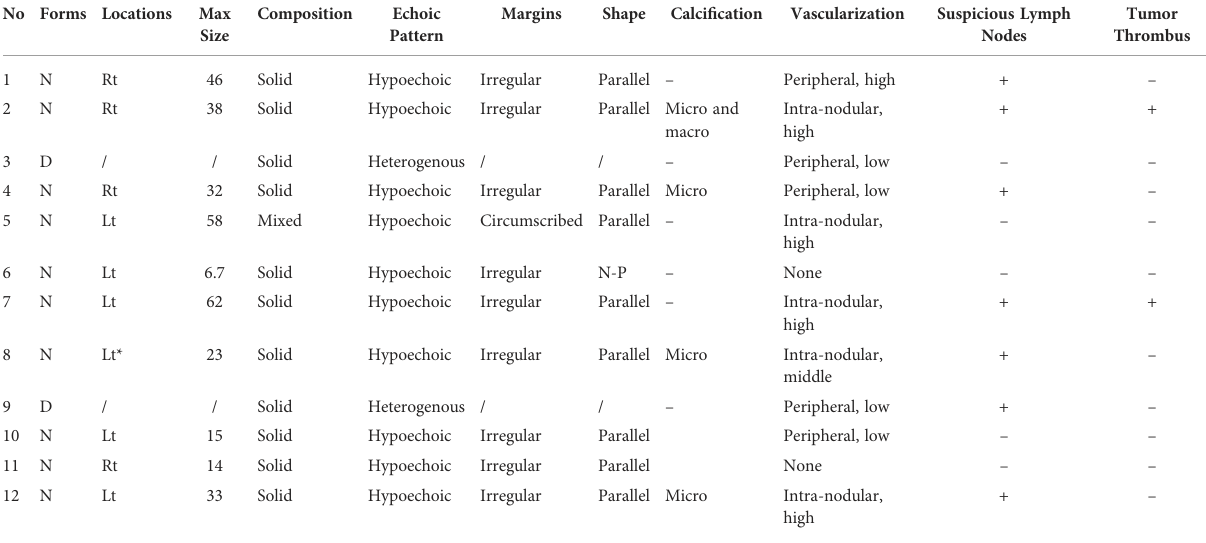
TABLE 2 Ultrasonographic characteristics of patients with metastases to the thyroid gland. No Forms